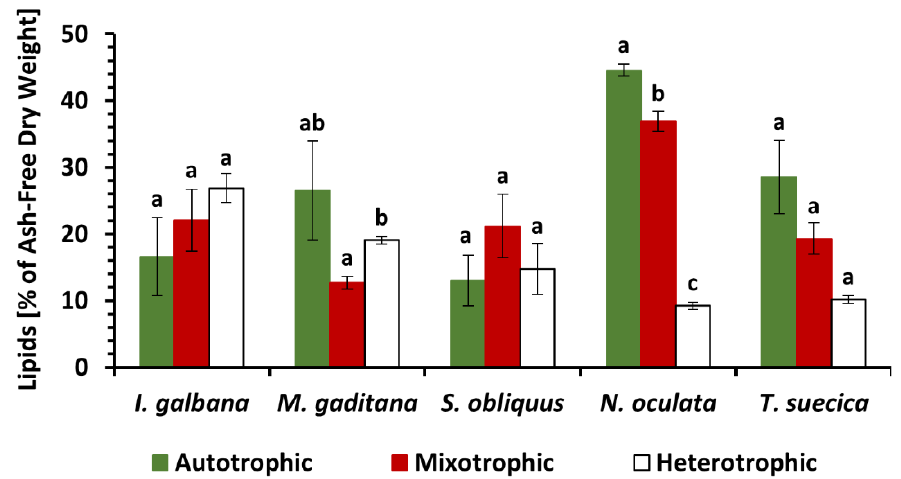
Figure 3. Total lipid content as percentage of ash-free dry weight. Error bars represent mean values ± standard deviation (n = 2), while small letters denote significant differences between the mean values obtained ( p < 0.05).